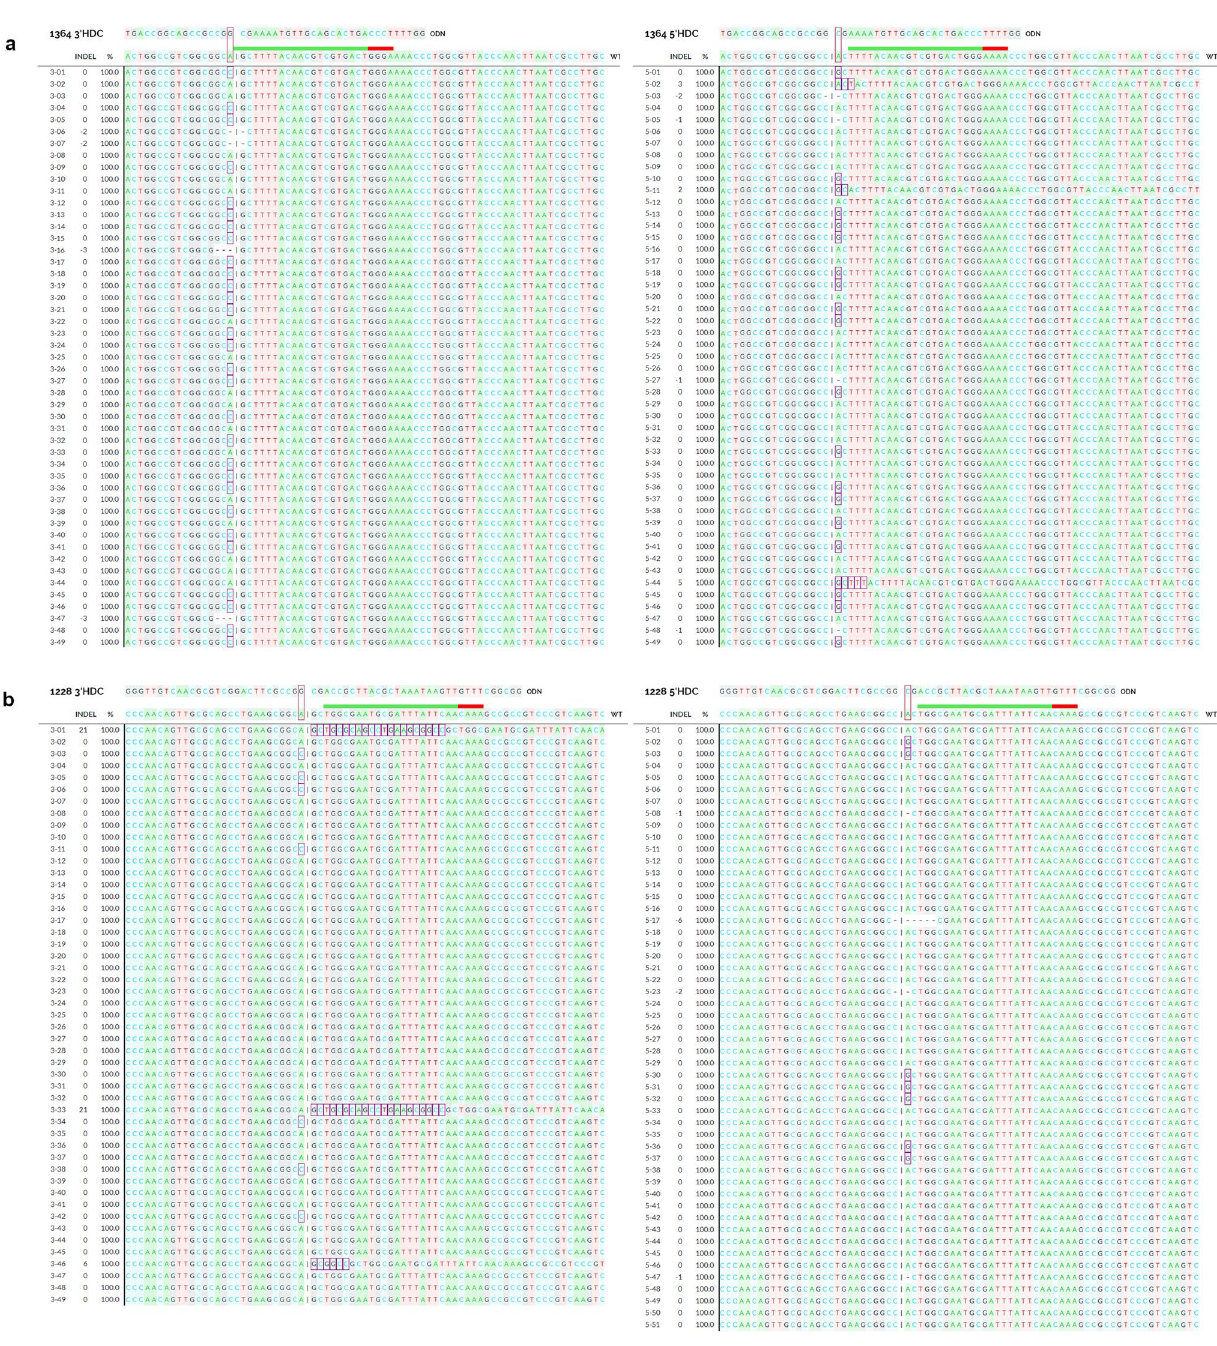
Figure 6. Sanger sequencing analysis of HDC repair outcomes. Individual clones were sequenced via Sanger sequencing to examine repair profiles of 3 ′ NotI-MT (left) and 5 ′ NotI-MT (right) at the ( a ) 1364 and ( b ) 1228 target sites. For each profile, a reference WT sequence of each NotI-MT plasmid is shown in alignment with the HDR correction template and the Cas12a target sites. The point mutations to be corrected are shown with the red boxes and the Cas12a cleavage sites are shown as a vertical dashed line. Aligned under the reference WT sequence, the individual repair profiles can be seen as insertions or modifications within purple boxes and deletions with dashed horizontal lines. Sanger sequencing analysis was done using DECODR (see “Materials and